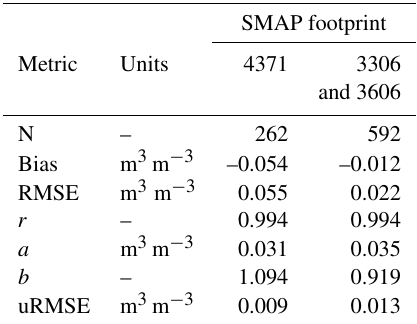
Table 2. Error metrics computed from matchups of the spatial soil moisture means derived from measurements collected at seven sta- tions and all stations within the respective footprint. N stands for the number of matchups, r is the Pearson product moment cor- relation coefficient, a and b are coefficients of a linear function, y = a + bx , between the two footprint averages derived as given by Eqs. (3a) and (b), and uRMSE is computed between the unbiased seven-station and all-station